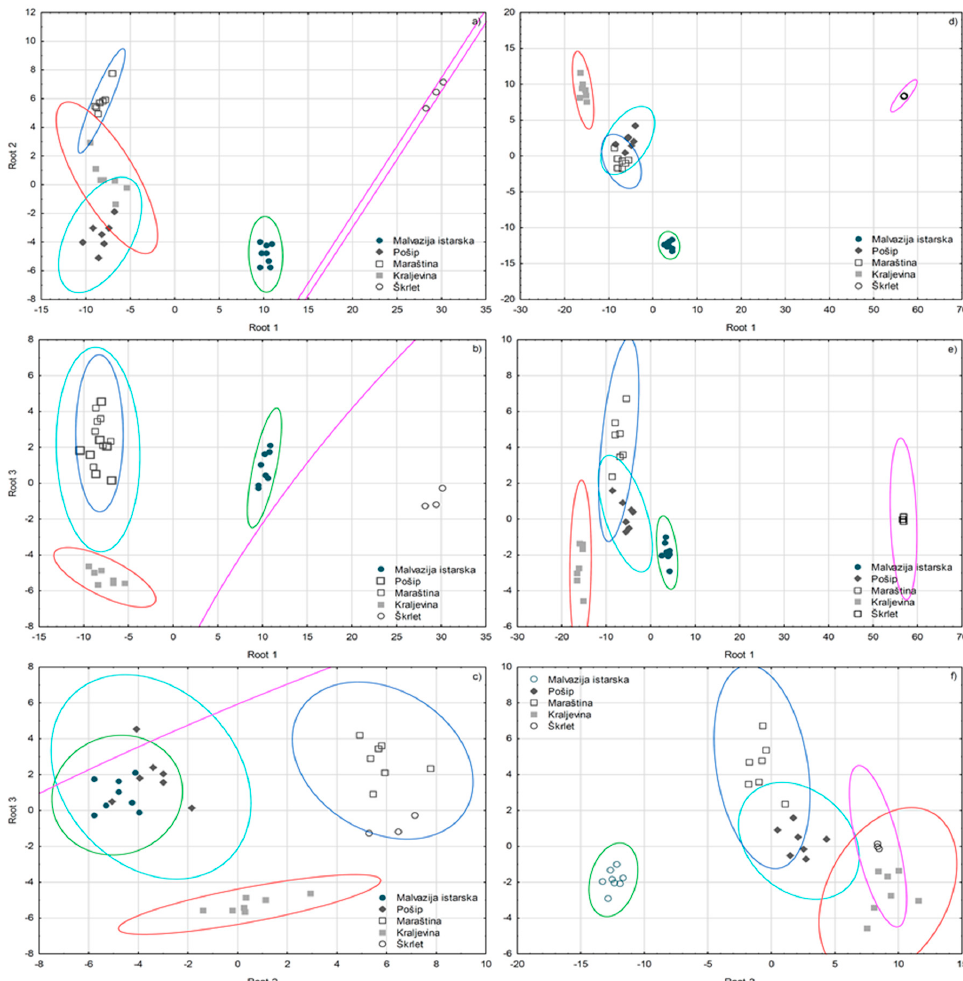
Figure 4. Separation of Croatian monovarietal wines according to variety defined by the first three discriminant functions (roots) obtained by forward stepwise discriminant analysis (SLDA) on the basis of volatile terpene composition determined by GC-MS ( a – c ) and GC×GC-TOF-MS ( d – f ) analysis.